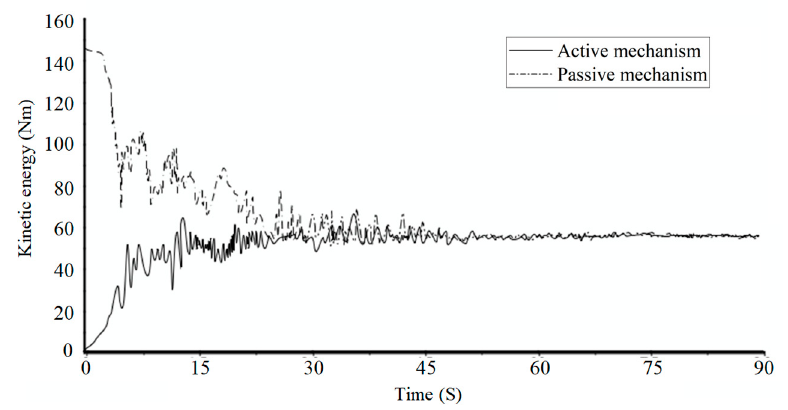
Figure 9. Variation of kinetic energy versus time.